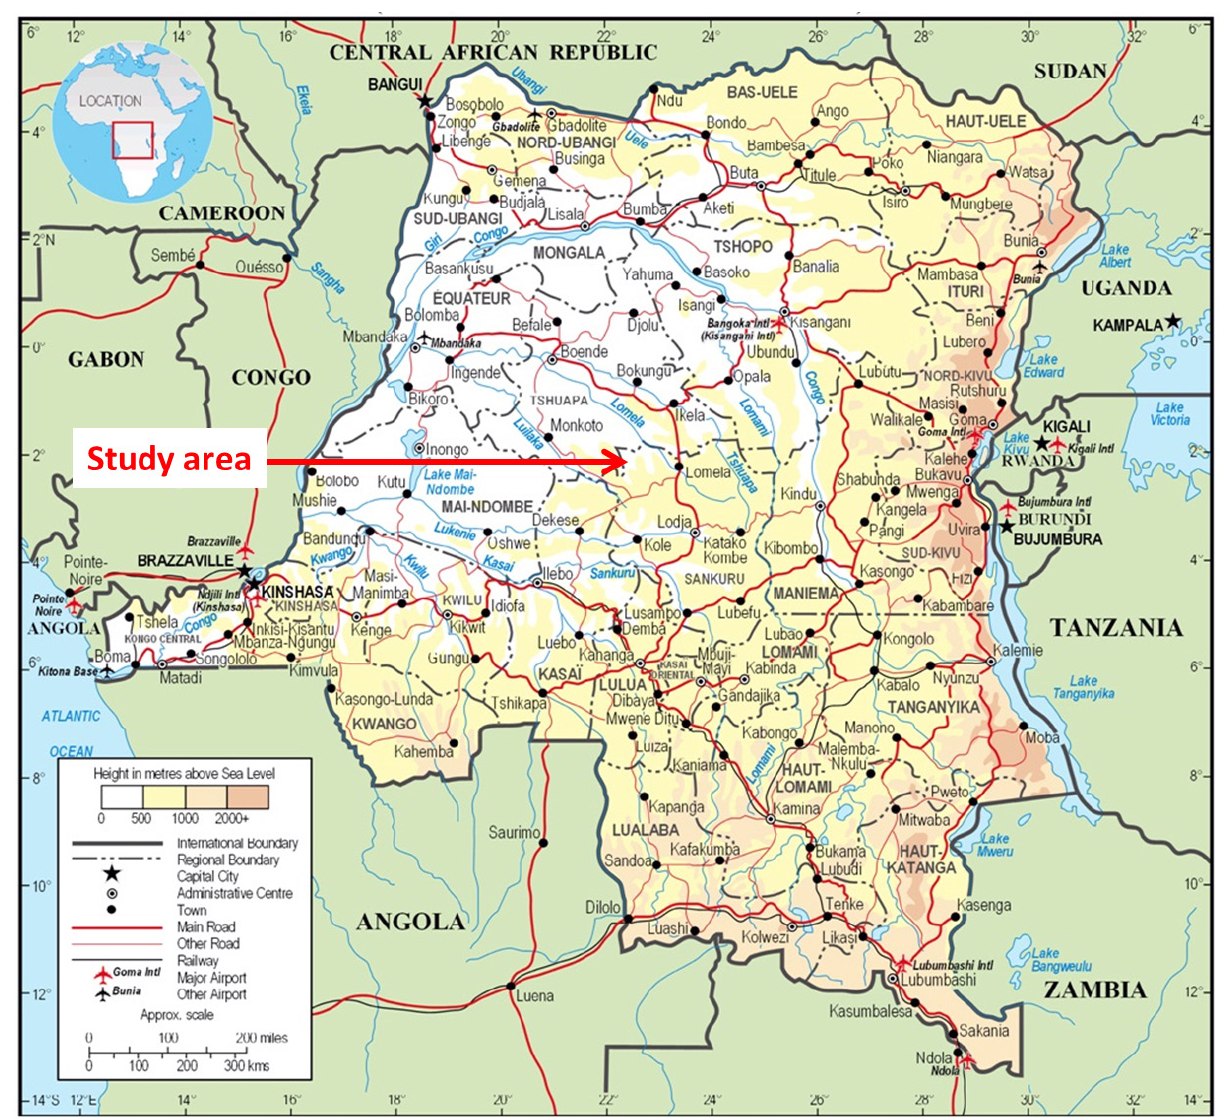
Figure 1. Location of study area in Democratic Republic of Congo.